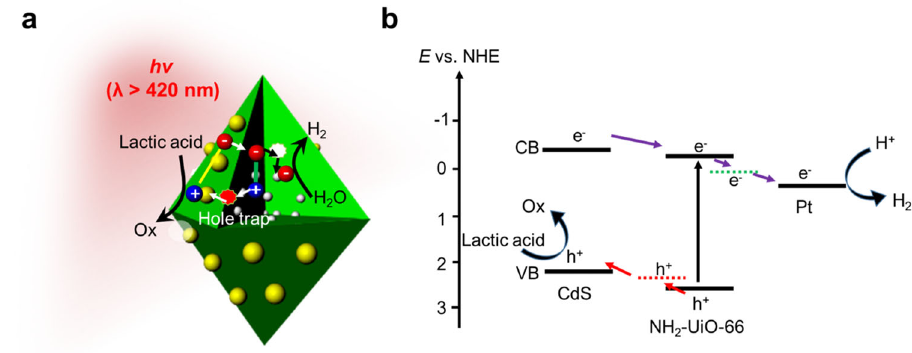
Fig. 4 Mechanism of photocatalytic HER. a Mechanism of photoinduced carrier dynamics for Pt@NH 2 -UiO-66/CdS, with a hole-trap transfer pathway for enhanced HER photocatalytic activity. b Band diagram of photocatalytic processes in Pt@NH